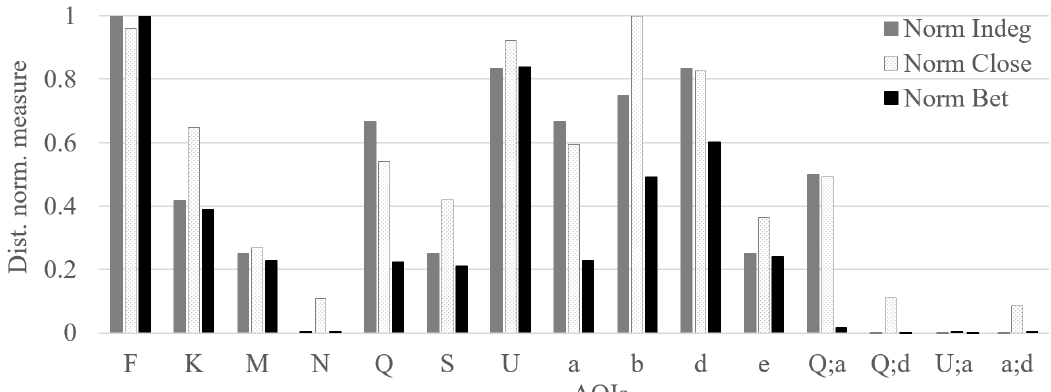
Figure 10. Distance normalized measure value for all AOIs present in the DNet for time interval 0-5 mins for P1 (see Figure 8(a)). “Norm Indeg,” “Norm Close,” and “Norm Bet” refers to normalized indegree, closeness, and betweenness values, respectively. The vertical axis represents the distanced normalized measure value. The vertical axis ranges from 0 to 1, thus it helps to analyze the relative importance of all three measures at a given time